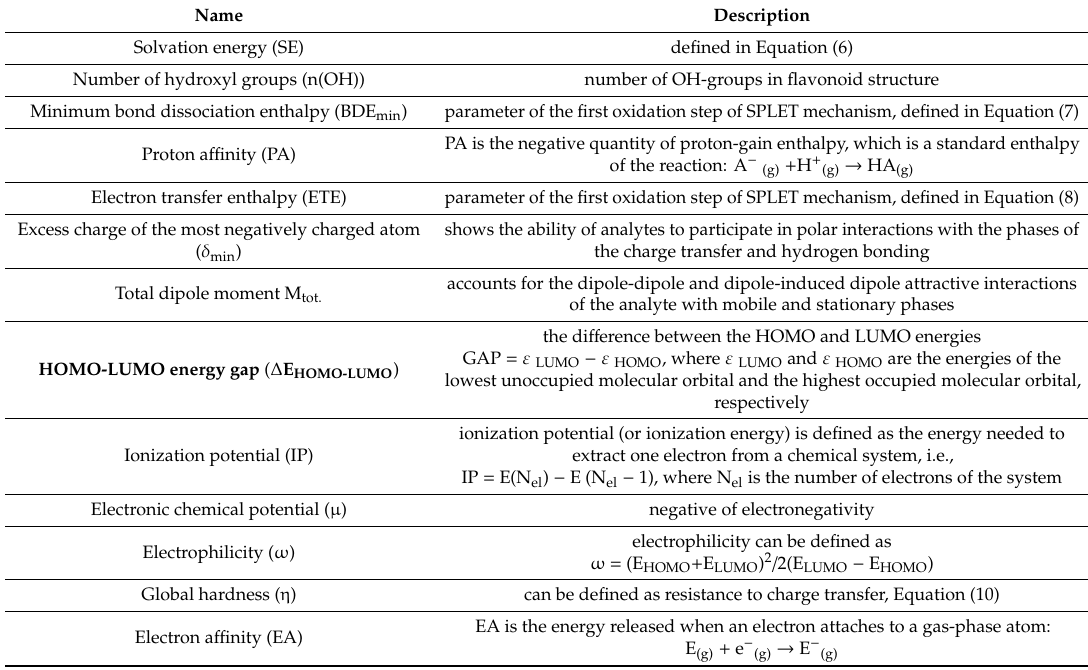
Table 6. Molecular descriptors used for GA-PLS quantitative structure retention relationships (QSRR)